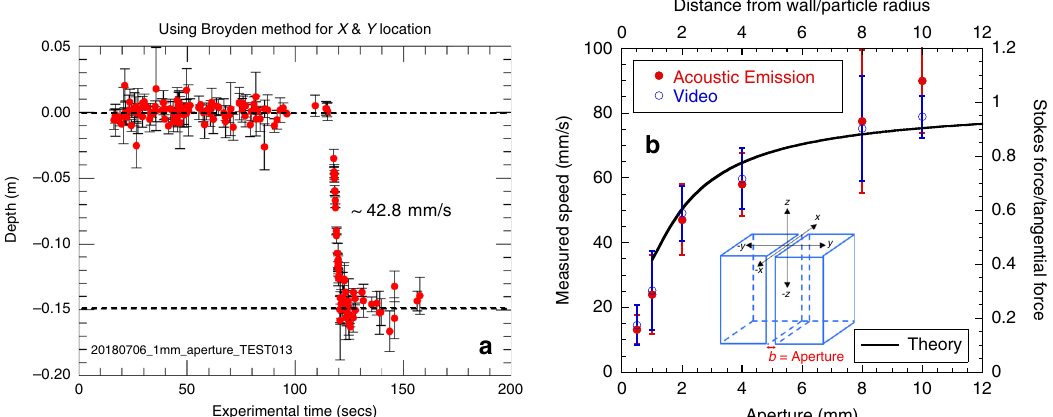
Fig. 5 Descent speed. a Depth of emitting grain of a dust in a 1 mm uniform-aperture fracture as a function of time. b Average dust speed as a function of fracture aperture from video image processing and acoustic emission localization (see Supplementary Note 6 for approach). Tangential drag decreases as the aperture of the fracture increases. Also shown is the theoretical prediction of the Stokes force normalized by the force from the walls, as a function of the ratio of distance of a sphere from the wall divided by the sphere radius, assuming the sphere is centered between the two